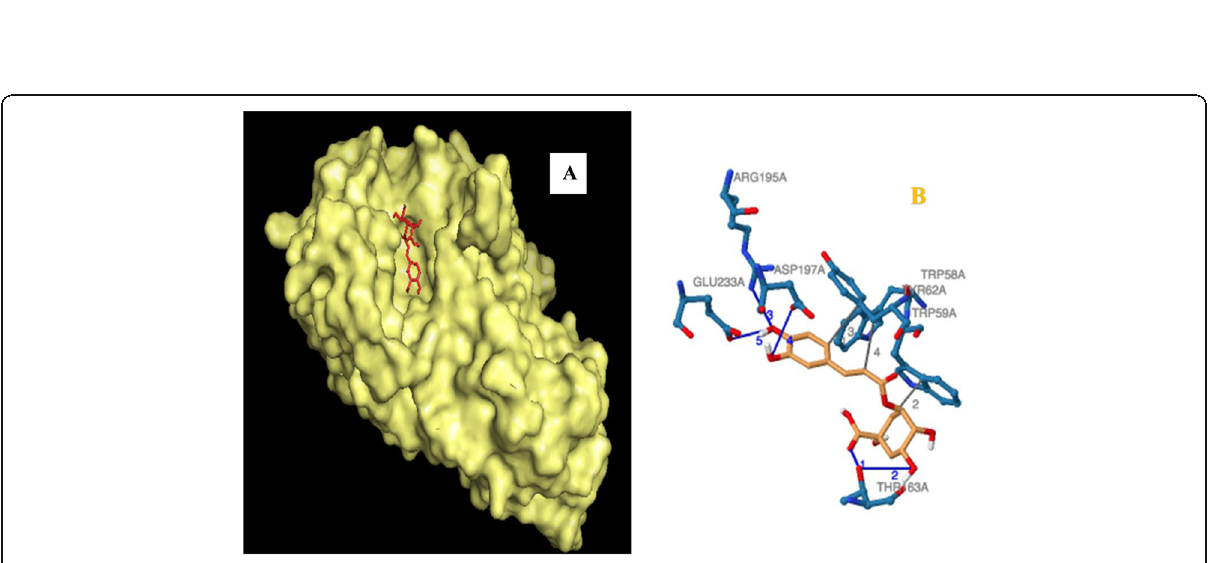
Fig. 9 Binding pose and binding site of chlorogenic acid with α - amylase (panel A), molecular interaction of chlorogenic acid with amino acid residues within the binding pocket of the protein structure (panel B)